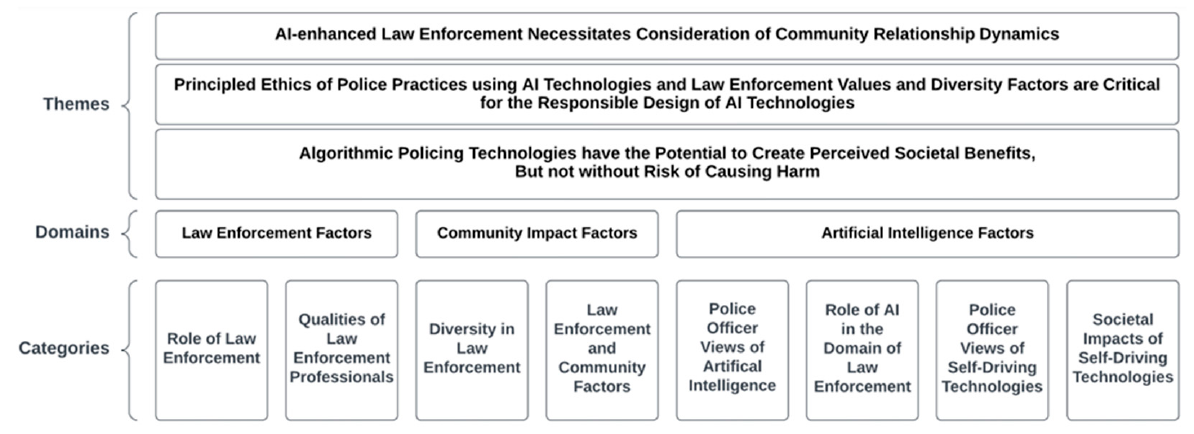
Figure 1. Overarching themes in law enforcement and artificial intelligence technologies.